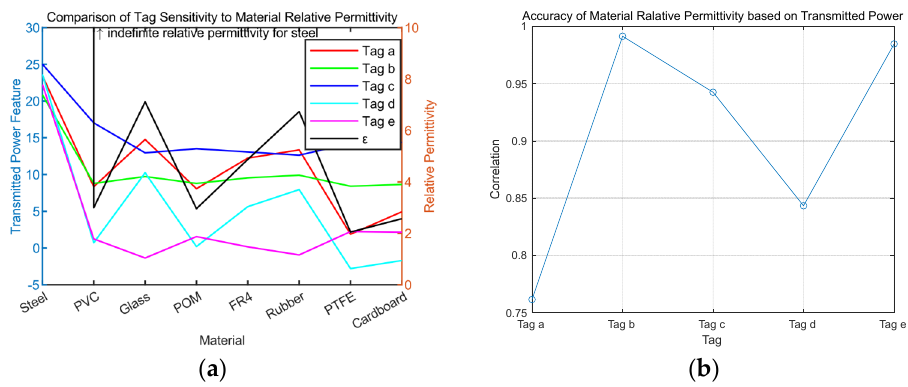
Figure 8. Transmitted power feature for relative permittivity measurement ( a ) results and ( b ) accuracy in correlation.